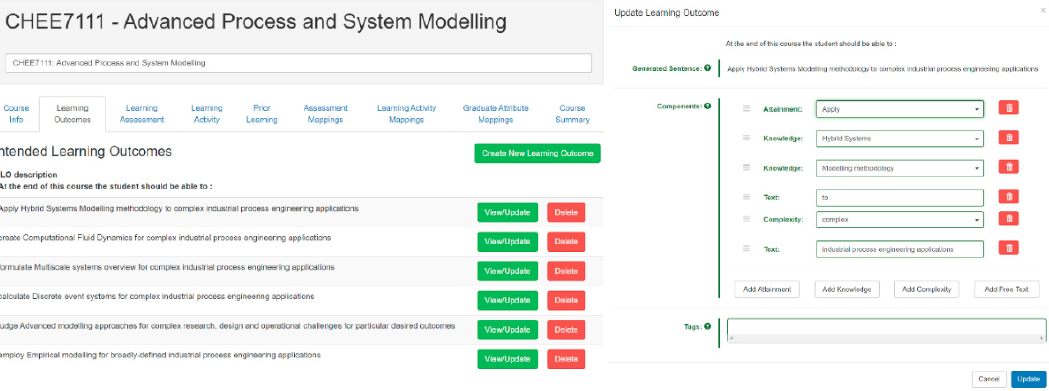
Figure 6. Example of intended learning outcomes (ILOs) (left) and the structured text ILO builder (right).